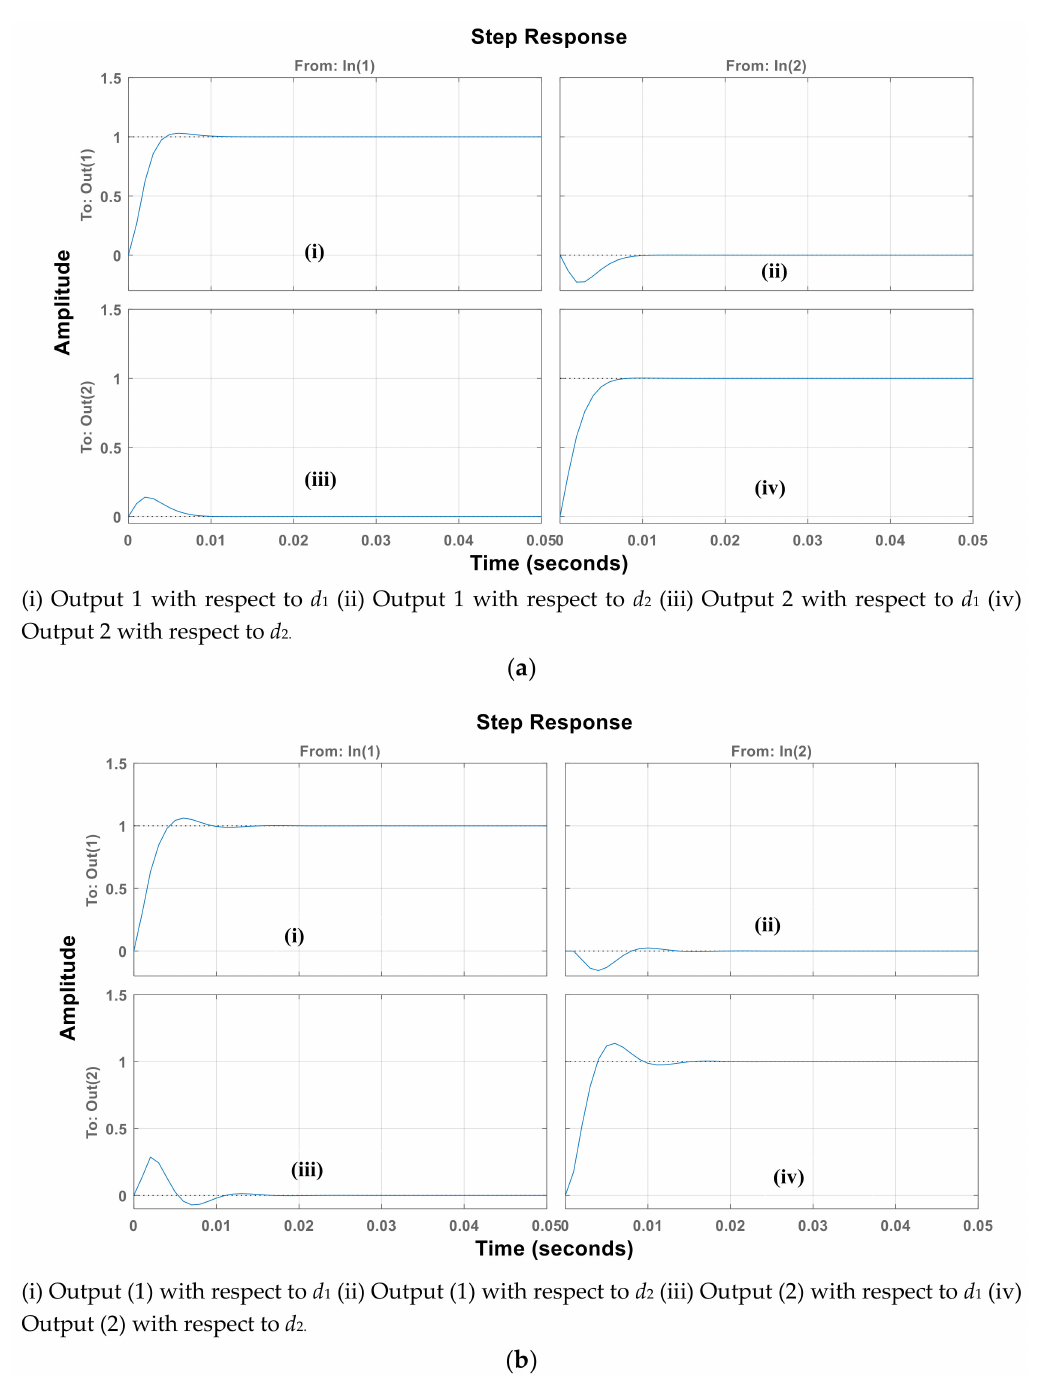
Figure 11. Response of unit step function ( a ) SIDO ( b ) DIDO